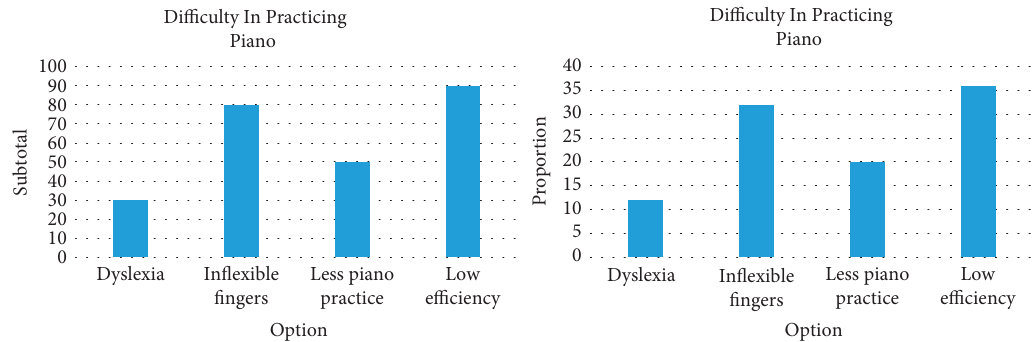
Figure 5: Difficulties encountered by students in piano learning (multiple choice).